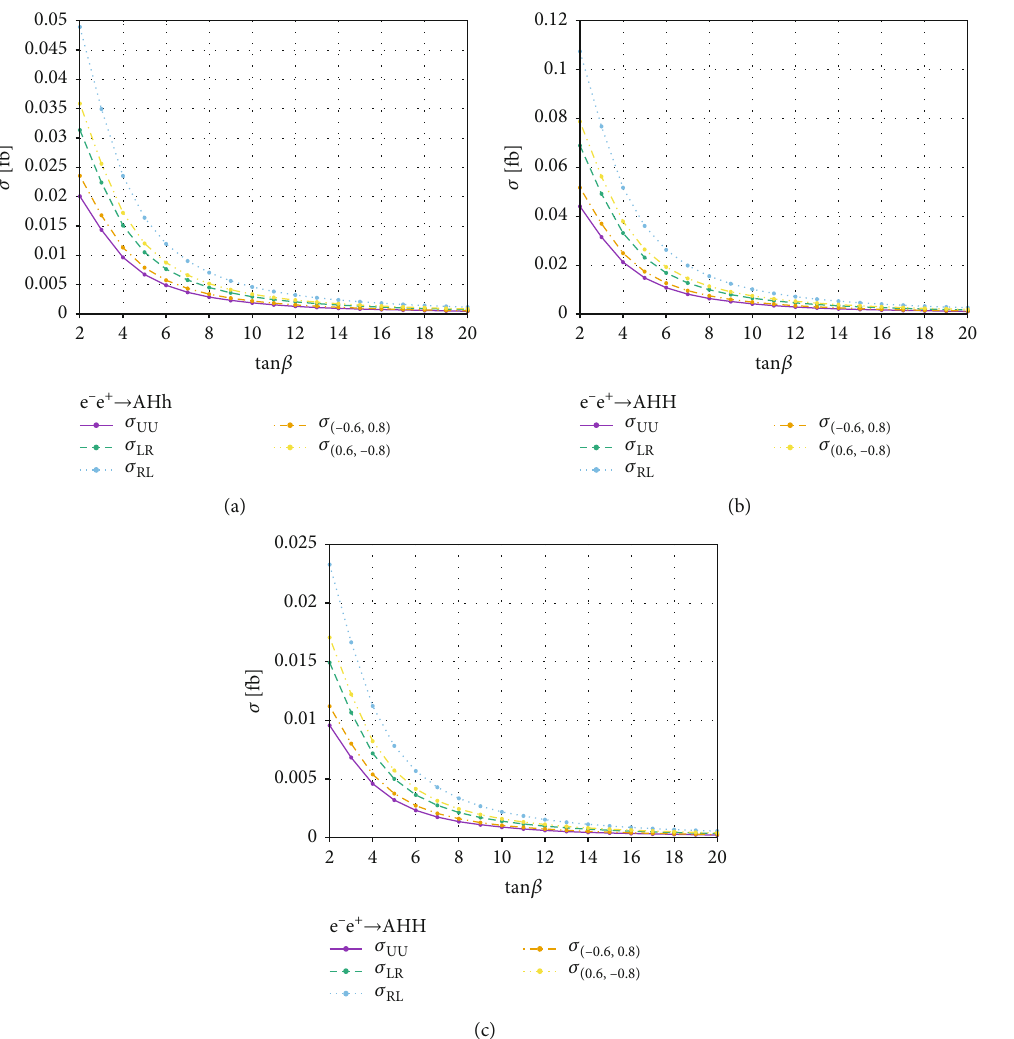
Figure 6: In fi gures, the production cross sections σ ð pp ⟶ AHH Þ are shown as a function of tan β at (a) 0.6TeV, (b) 1TeV, and (c) 3TeV